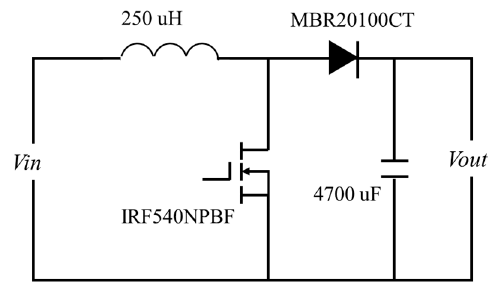
Figure 5. The circuit diagram of the power converter.